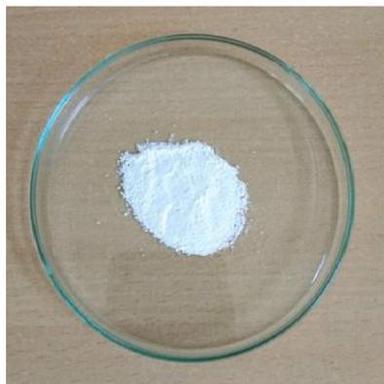
Synthesized sample of RbCl doped MgO nanomaterial.